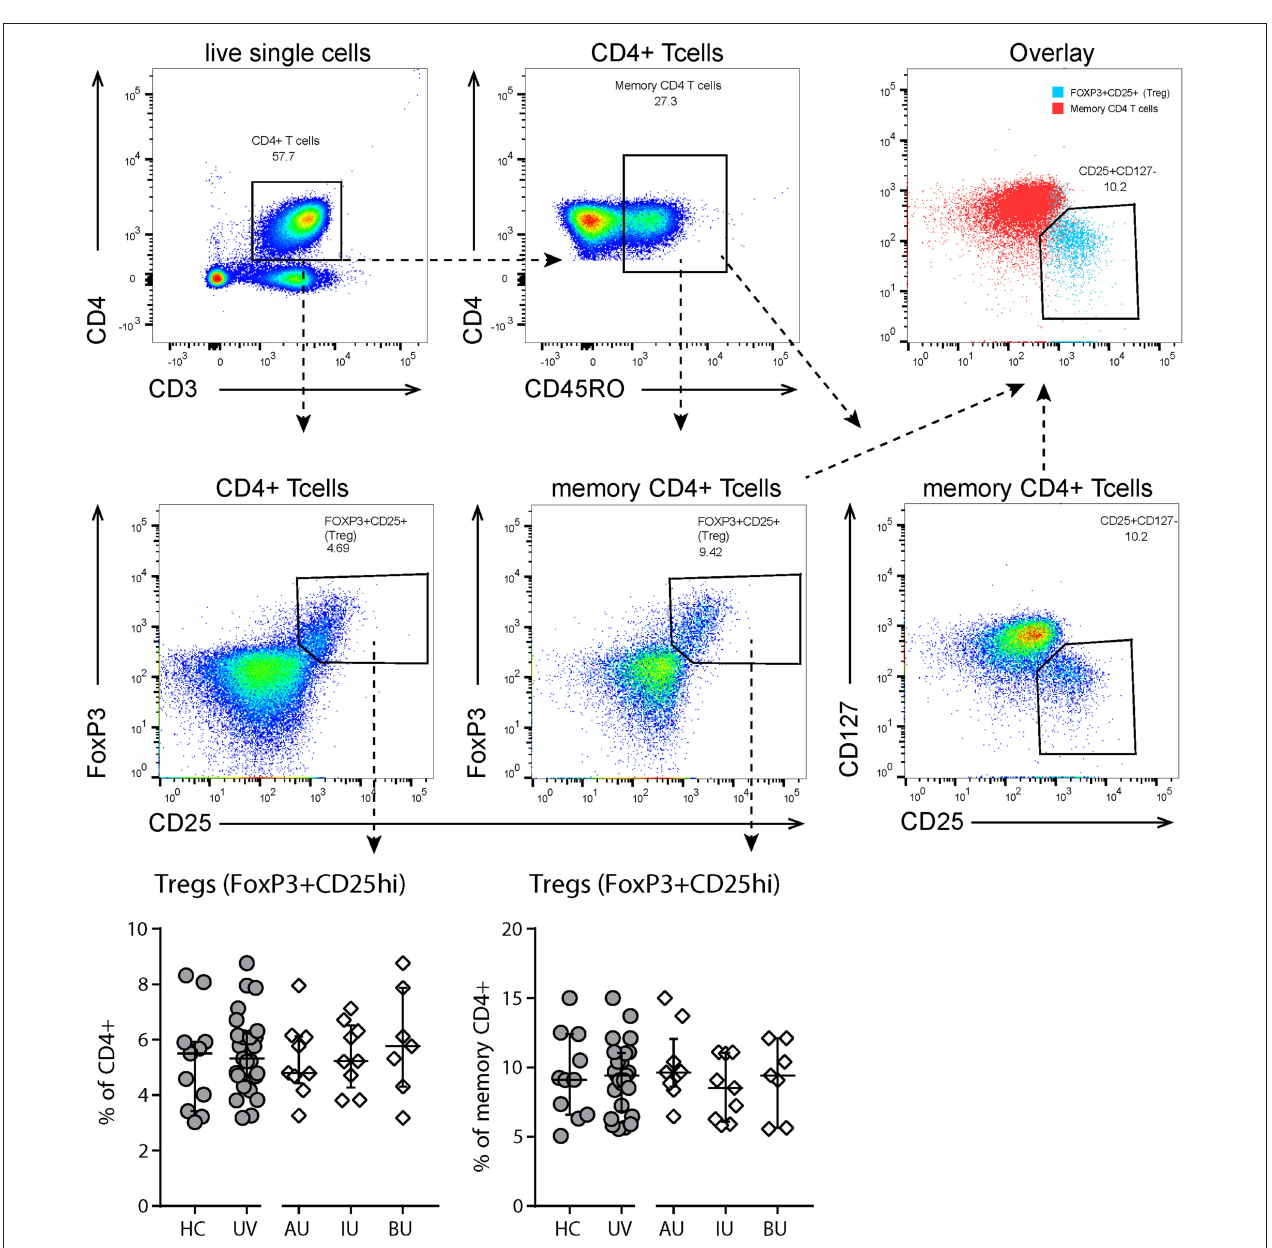
FIGURE 3 | Flow cytometry analysis of T regulatory cells. Top and second row: gating strategy used to identify T regulatory (Treg, CD25highFoxP3 + ) cells. Live single cells are gated as indicated in Figure S1 . Bottom row: levels of circulating Tregs as % of (memory) CD4 + T cells. All Tregs are also CD127- (see “overlay” plot). Bars in scatter plots indicate median, error bars indicate interquartile range. Abbreviations: AU, HLA-B27 associated anterior uveitis; BU, Birdshot uveitis; HC, healthy control; IU, idiopathic intermediate uveitis; UV, Combined uveitis samples.